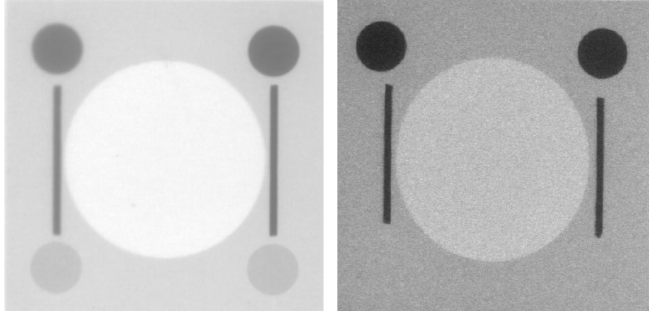
Fig. 8. The resulting image of the BPI for the OB (left) and CB (right) configurations. Note: the intensities of grey values are not comparable due to the lower neutron flux for the CB